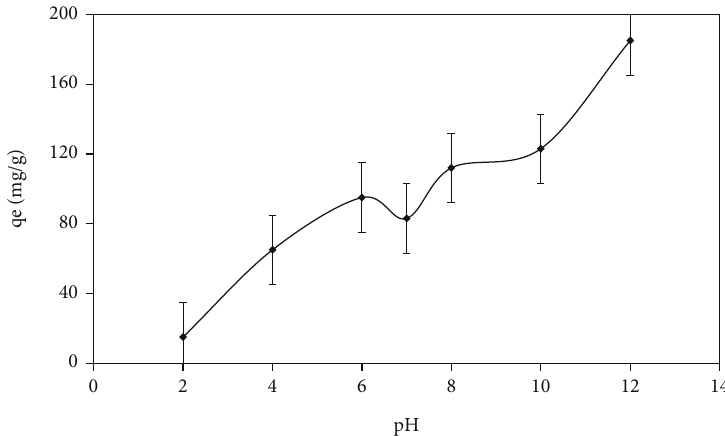
Figure 8: Graph of pH e ff ect on CV (adsorbent dose: 0.05g L -1 ; room temperature; and contact time: 3 hrs).